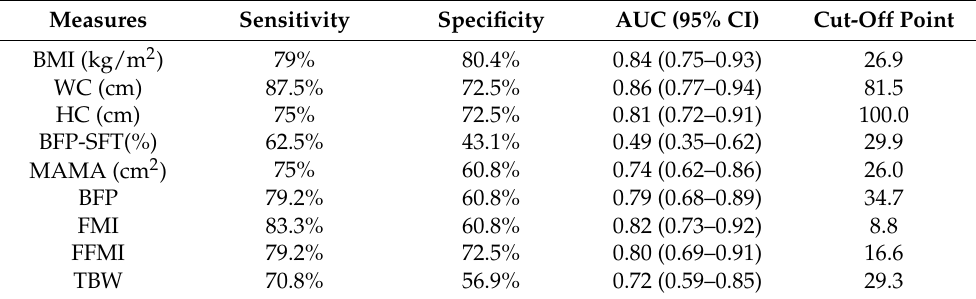
Table 3. Sensitivity and Specificity of BMI, WC and anthropometric measures, BIA tests, and their cut-off points for diagnosing Metabolic